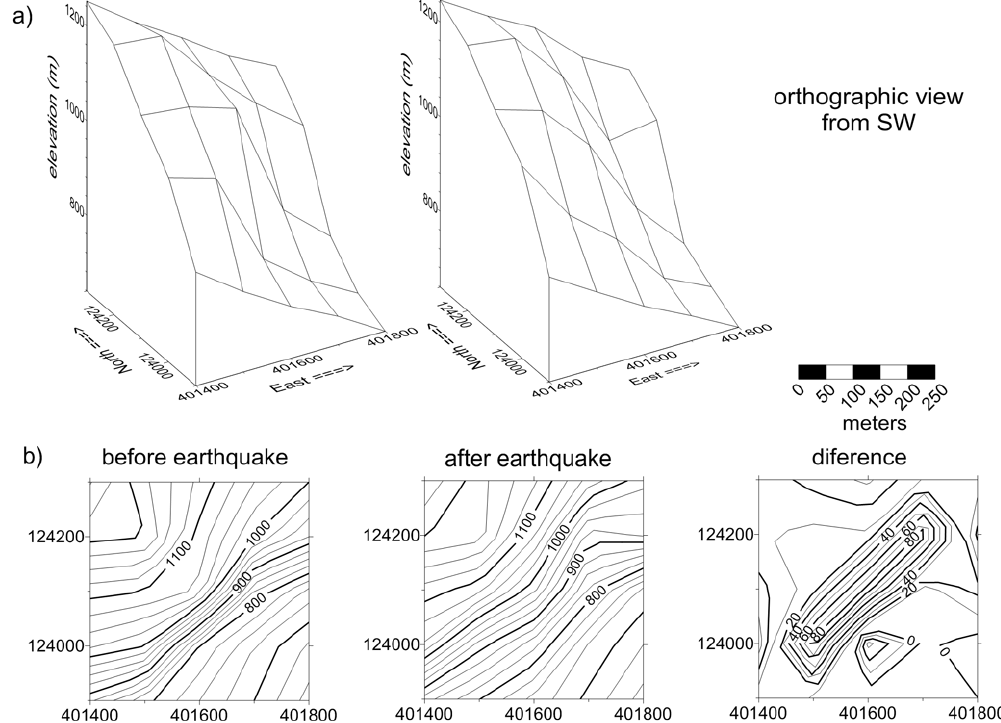
Fig. 8. Digital elevation model of Osojnica mountain showing pre- and post-earthquake topography in (a) perspective view and (b) contour maps together with the map of differences between both models.